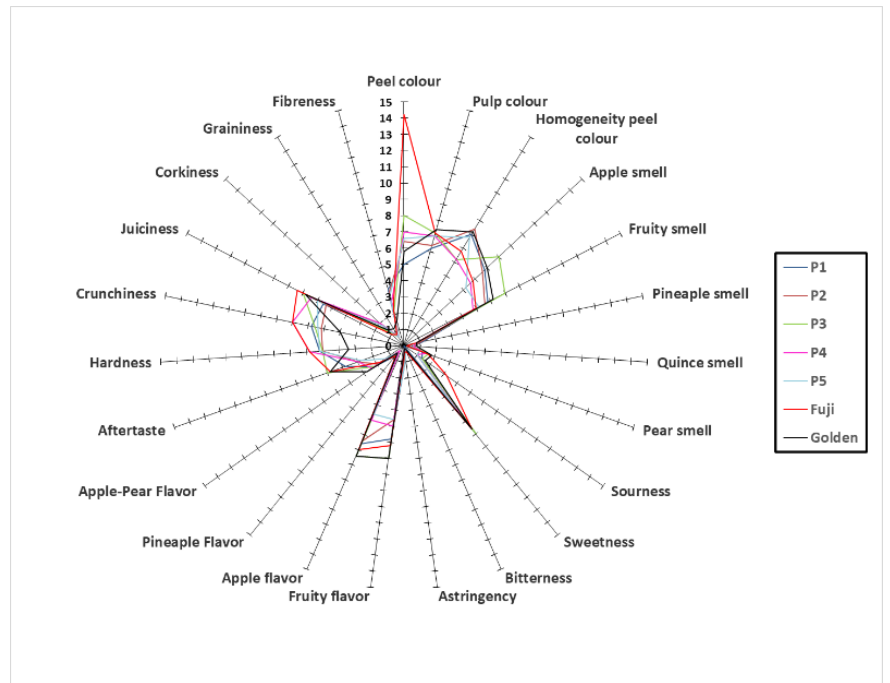
Figure 2. Sensory scores the five clones of “Pero de Cehegín” and two varieties of reference (“Fuji” and “Golden Delicious”) harvested at maturity in 2017. Sensory scores ranged from 0 (not detectable) to 10 (strong), except color which ranges between 0 and 20.